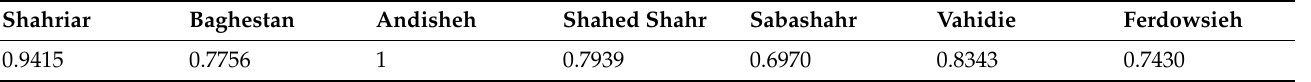
Table 6. Evaluation results.